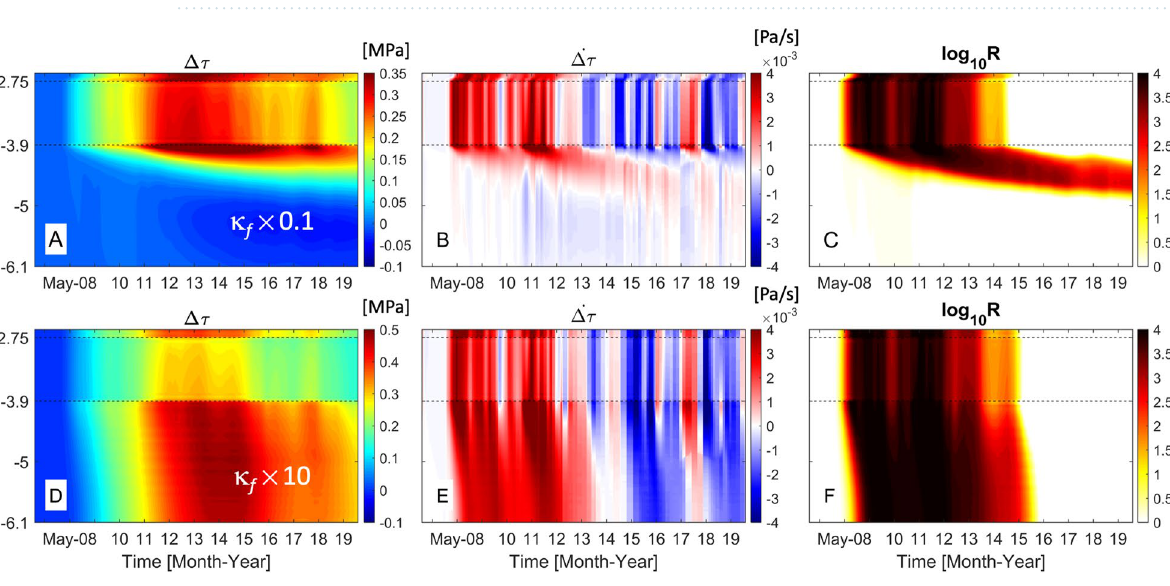
Figure 6. Spatio-temporal distribution of changes in total Coulomb stress, Coulomb stressing rate and seismicity rate in base 10 logarithmic scale along the fault line for variation in WVF permeability: ( A – C ) less 2.49 10 − 16 m 2 ) and ( D – F ) more permeable fault ( κ f permeable fault ( κ f = ×